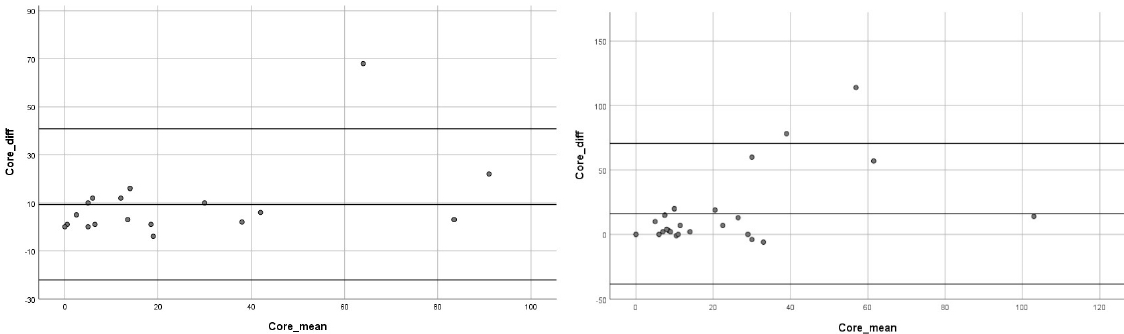
Figure 4. Secondary analysis Bland–Altman plot for the tandem group (on the left ) and the MCA– LVO control group (on the right ).